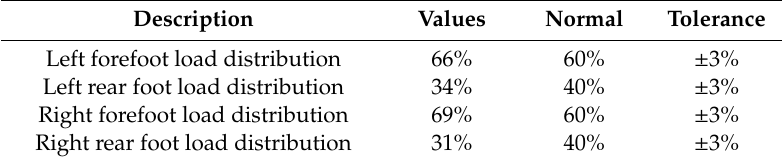
Table 1. Dynamic state load distribution values obtained with a gait analysis.